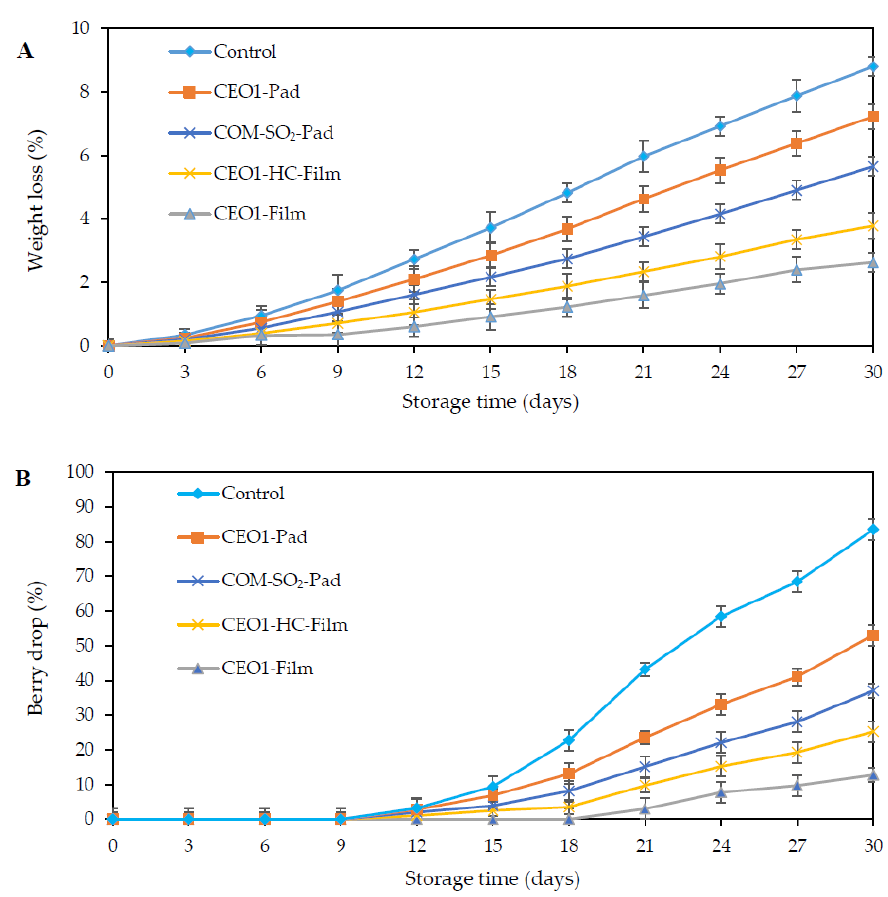
Figure 3. Weight loss ( A ) and berry drop ( B ) of TG without and with CEO antifungal packaging. Values are mean ± standard deviation (n = 6). See Figure 2 caption.